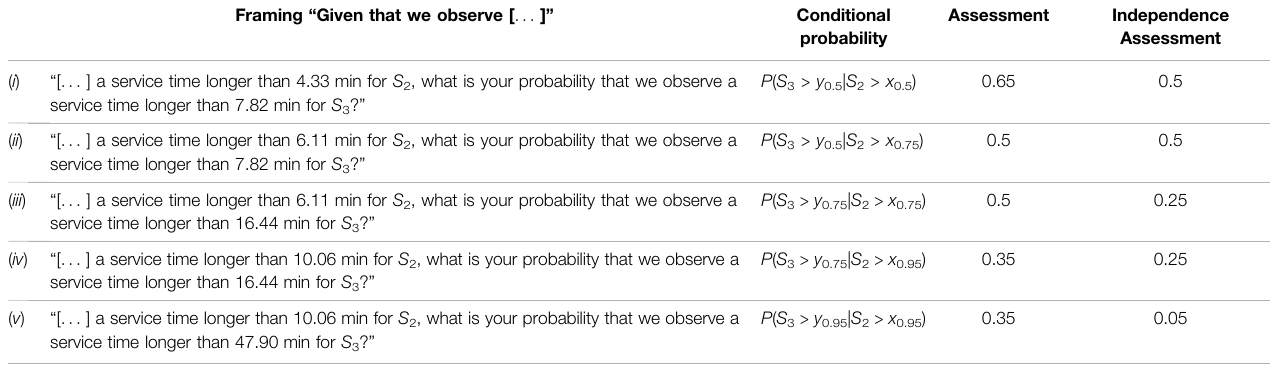
TABLE 1 | Overview of dependence elicitation procedure and results for C 2 . Framing “ Given that we observe [ ... ] ”